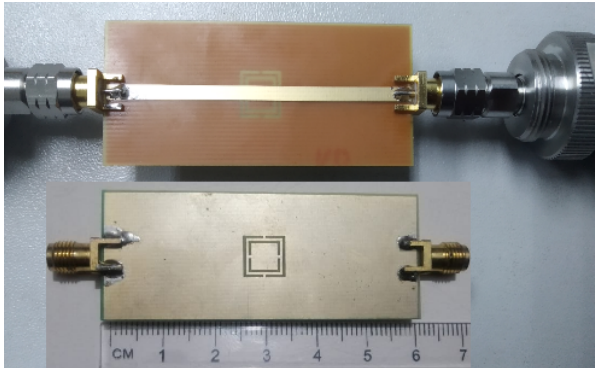
Figure 10. Fabricated prototype of the proposed sensor.